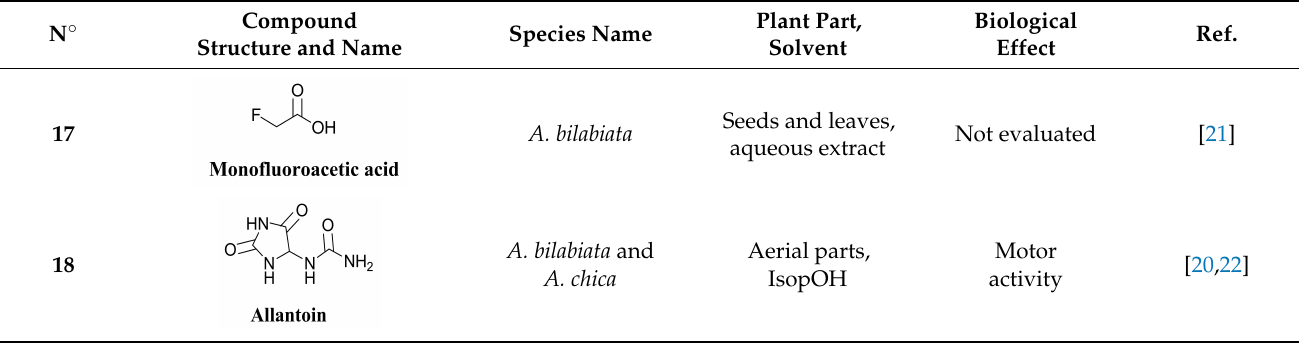
Table 4. Structure and bio-pharmacological properties of isolated compounds from A. bilabiata